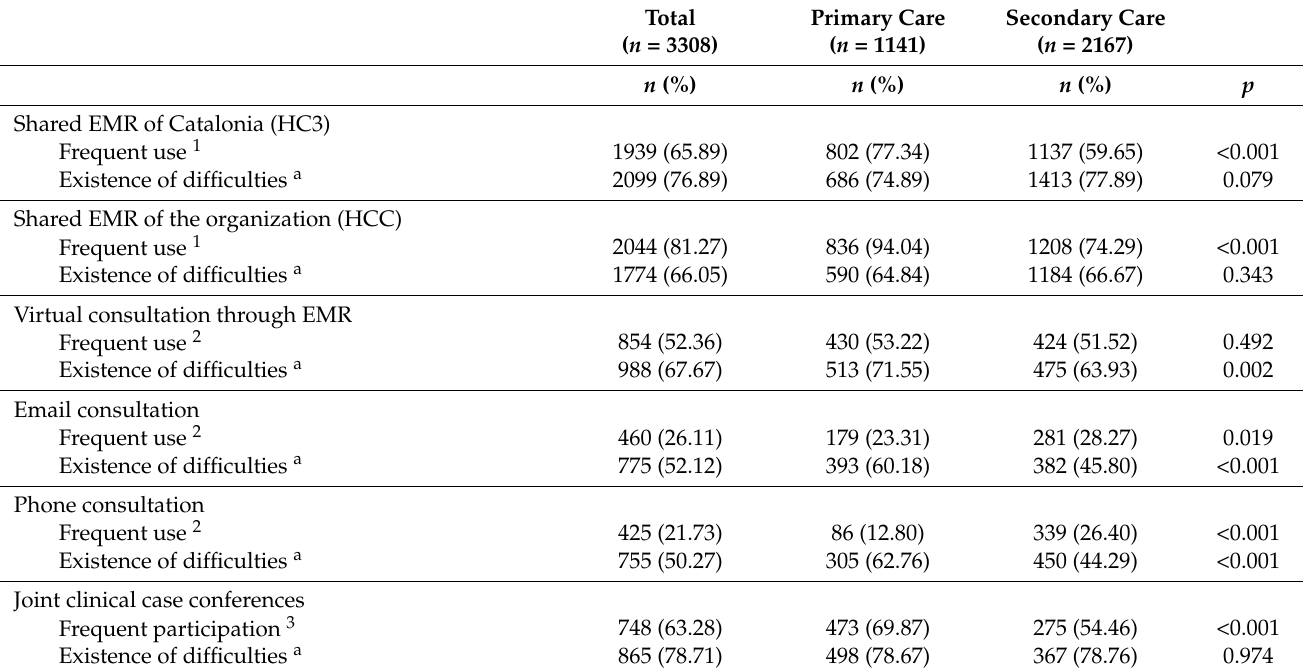
Table 2. Frequency of use and existence of difficulties in use of clinical coordination mechanisms, by level of